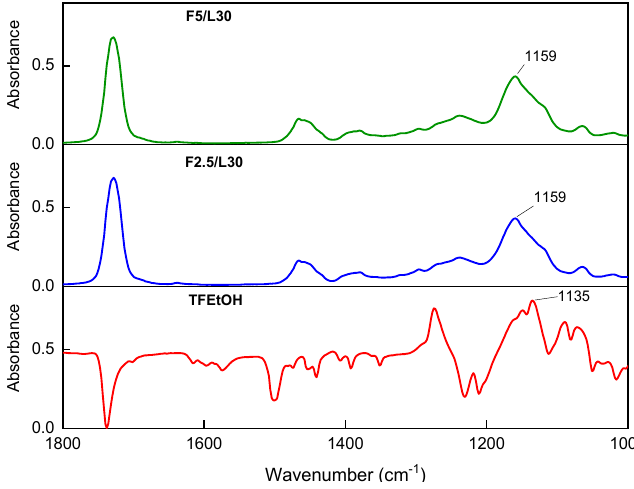
Figure 5. FTIR spectra of the fluorotelogen and fluorotelomers.